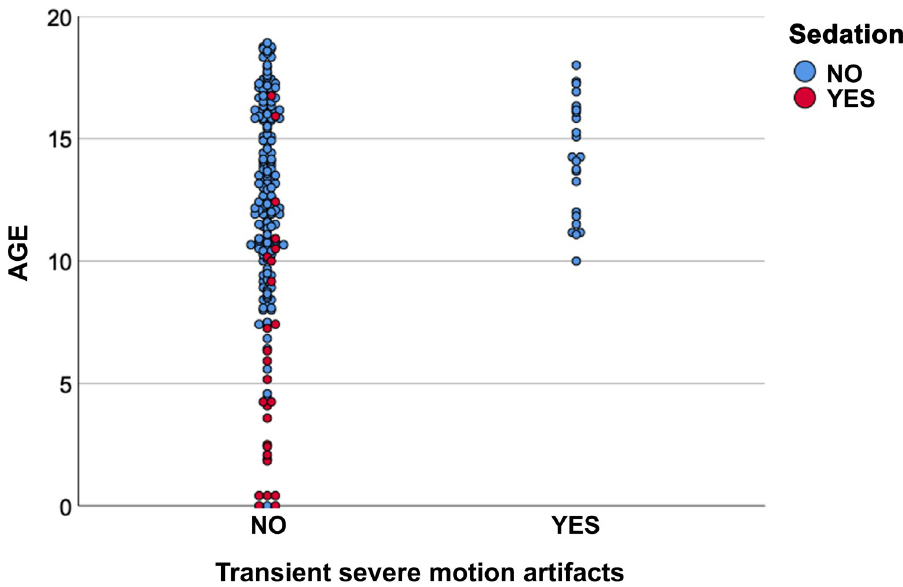
Fig 3. Relation of age and transient severe motion artifacts in patients with and without